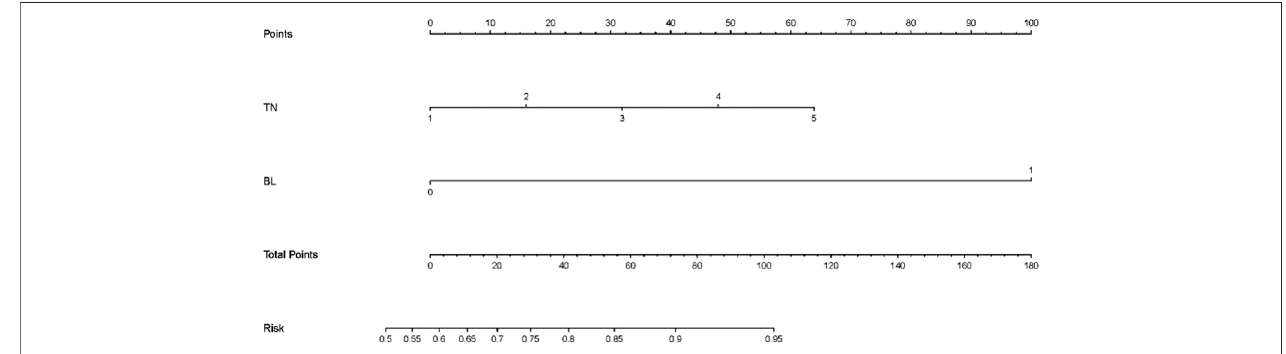
FIGURE5| NomogramforTACErefractoriness.TN:tumornumber;BI:bilobularinvasion.Accordingtoapatient ’ scondition,locatethepatient ’ spointontheTN/BI axisanddrawalineupwardsto fi ndthecorrespondingpoint.Thesumofthesetwopoints(variables)canthenbelocatedonthetotalpointsaxis,andalineistobedrawn downwards to match the likelihood of developing TACE